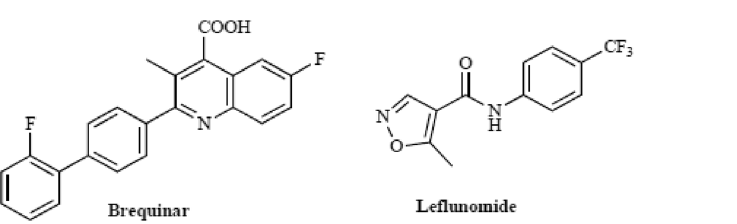
Figure 1. Schematic diagram illustrating reactions catalyzed by DHODH.